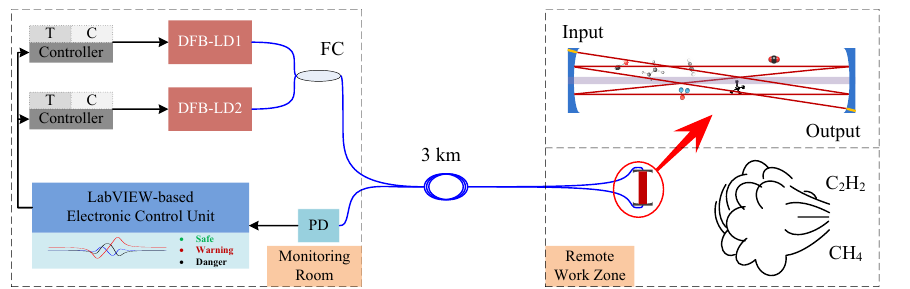
Figure 3. Schematic of the remote sensing system for simultaneous CH 4 and C 2 H 2 detection. T,